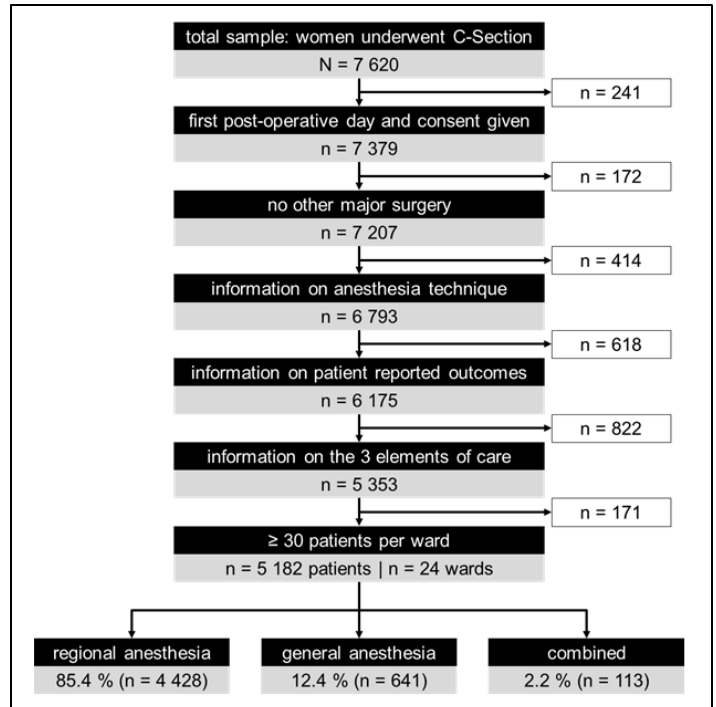
Figure 1. Study flow chart.